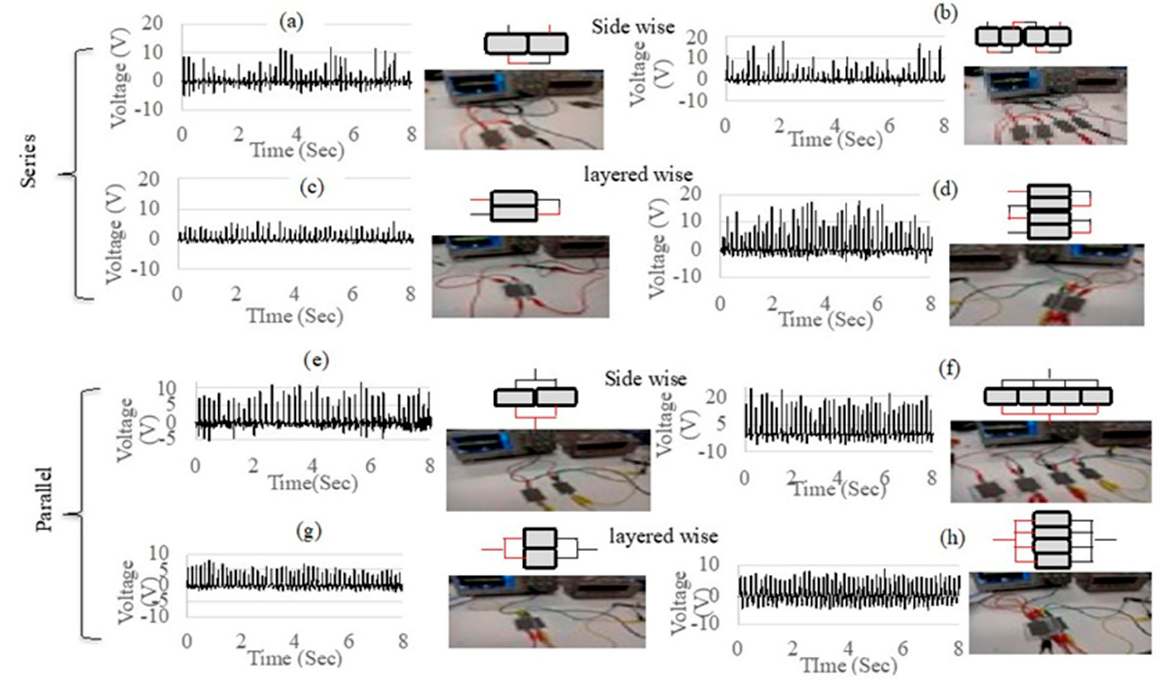
Figure 6. Oscilloscopic response from generating an output voltage via multiple sensors connected in series ( a – d ) and in parallel ( e – h ); ( a , b , e , f ) sidewise and ( c , d , g , h ) layer ‐ wise connected PSTS.